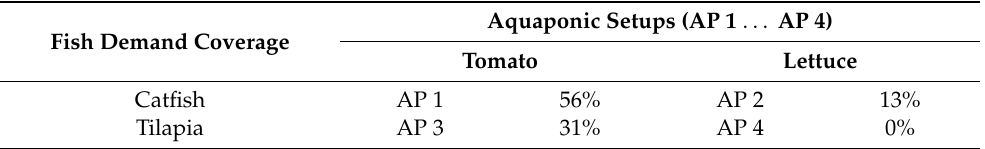
Table 3. Upscaled-AP scenario: Four aquaponic setups as combinations of catfish/tilapia and tomato/lettuce and their respective share to meet the freshwater fish demand of Berlin.